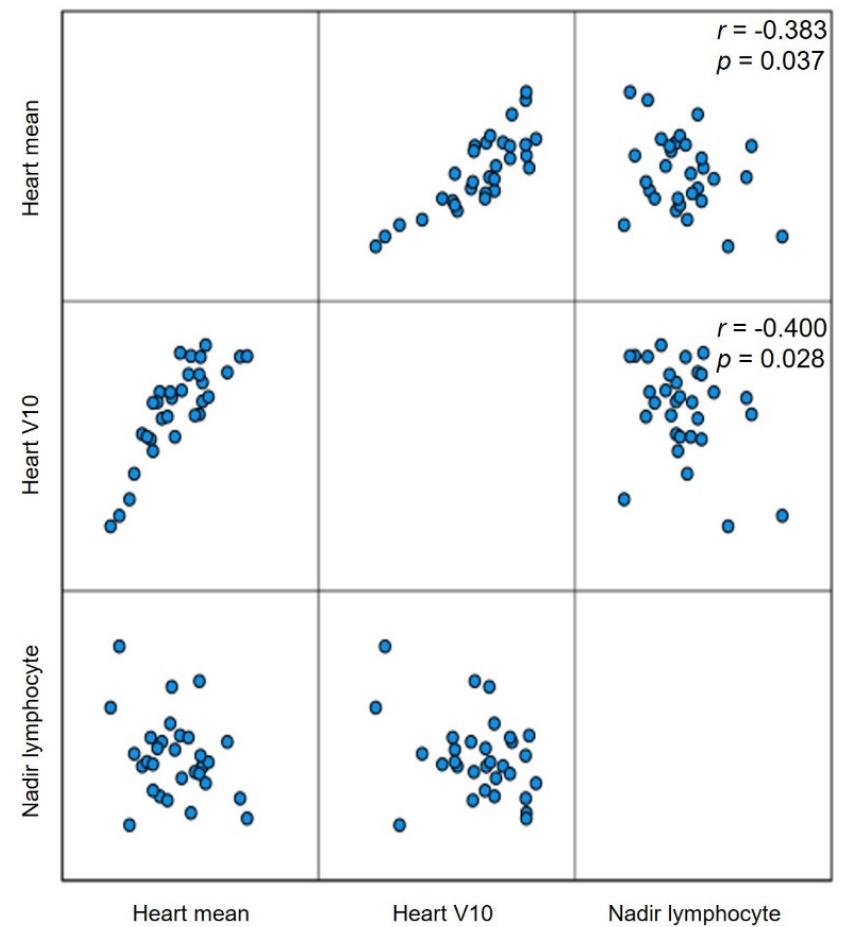
Figure 2. The correlation of the nadir of absolute lymphocyte count (Nadir lymphocyte) during the neoadjuvant chemoradiotherapy for locally advanced esophageal squamous cell carcinoma and the dosimetric parameters such as mean radiation dose to heart (Heart mean) and percentage of heart volume exposed to 10 Gy or more (Heart V10).